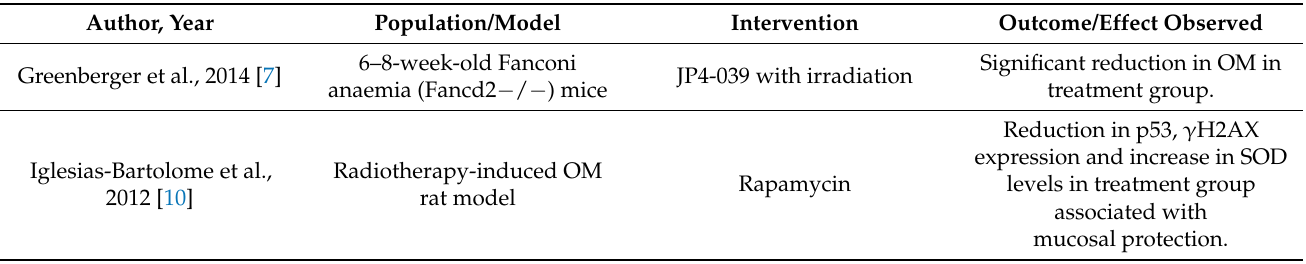
Table 2. Summary of in vivo studies and main